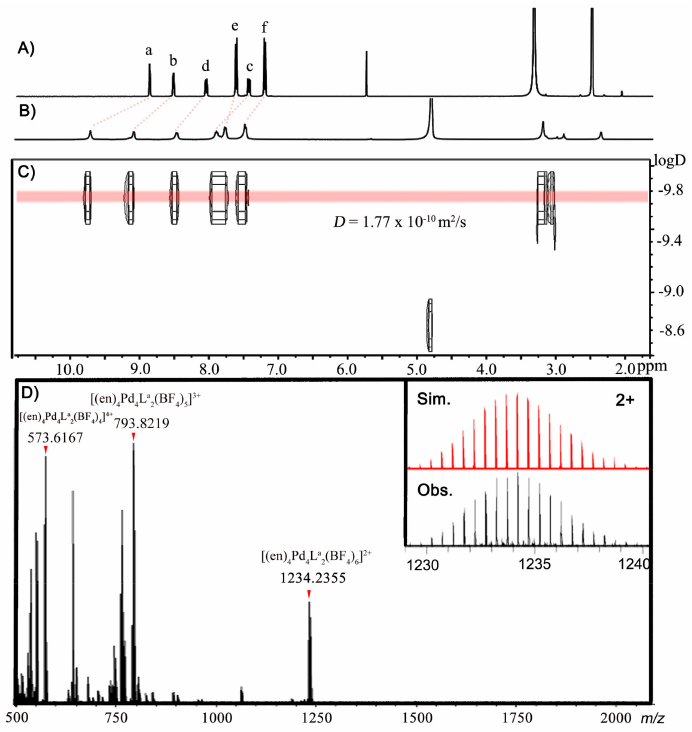
Figure 1. 1 H-NMR spectra of ( A ) ligand L a (400 MHz, DMSO- d 6 , 298 K), ( B ) complex 1 (400 MHz, D 2 O:Acetone- d 6 = 1:1, 298 K); ( C ) 1 H DOSY spectrum and ( D ) ESI-TOF-MS of complex 1 with